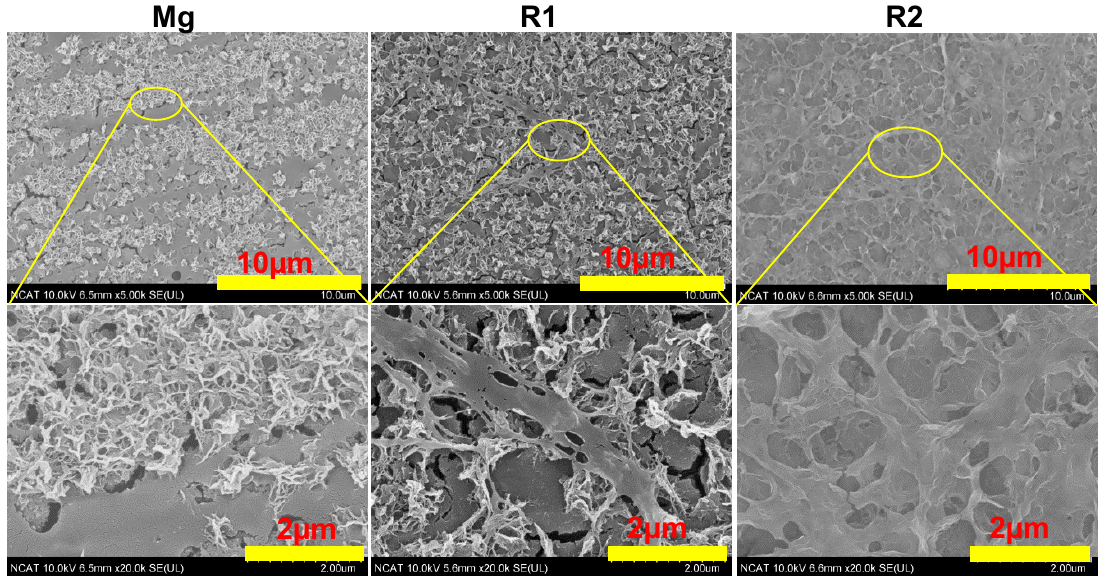
Figure 1. SEM images of type I collagen coating morphologies. All three materials were